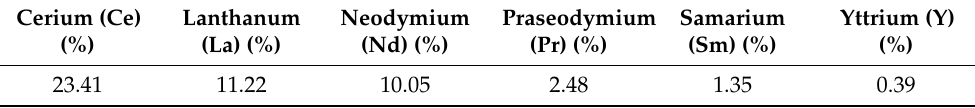
Table 2. Concentration of different REEs in the analyzed monazite